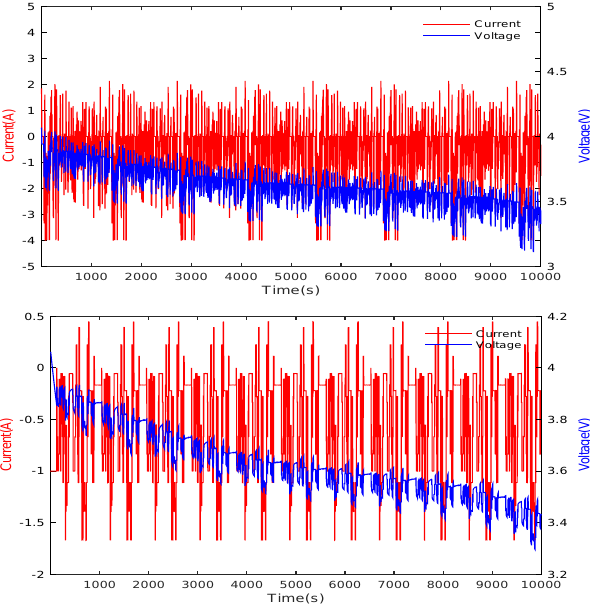
Figure 9. Current and voltage profiles of the operation conditions: FUDS and